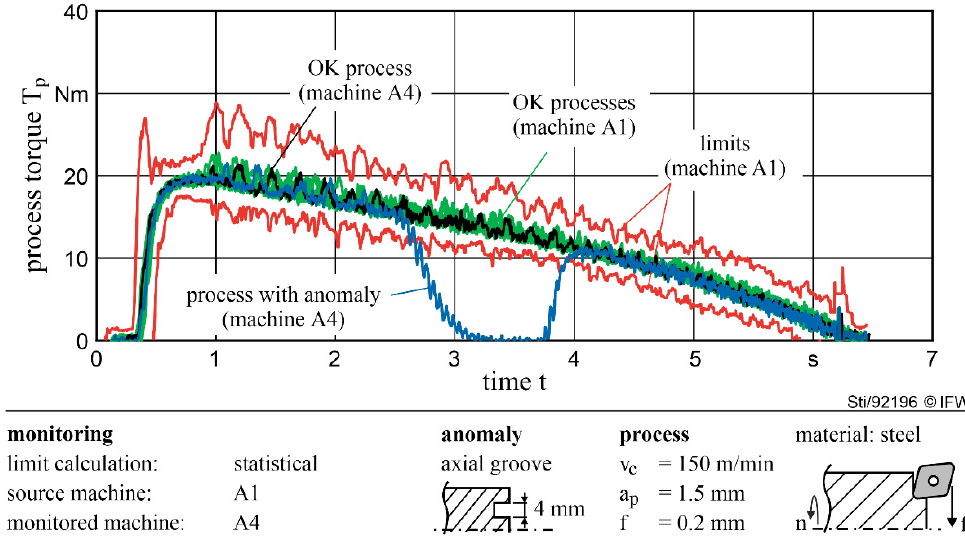
Figure 5. Successful detection of an abnormal process on the target machine using statistical monitoring limits sourced from a similar machine. No false alarms